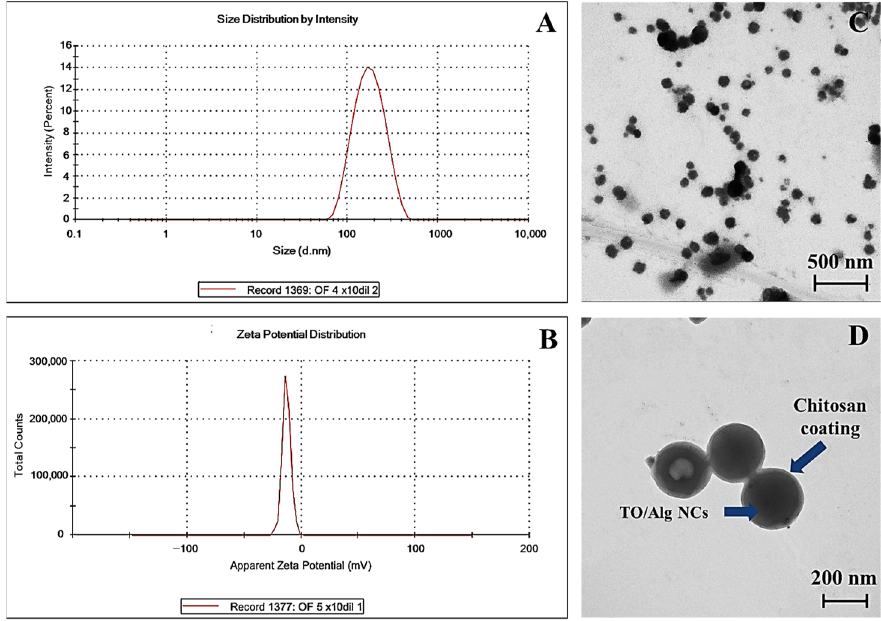
Figure 2. Physical characteristics of TO-CS/Alg-NCs. ( A ): Size distribution by intensity, ( B ): Zeta potential distribution, ( C , D ): TEM images at 50,000 and 100,000× magnification, respectively.